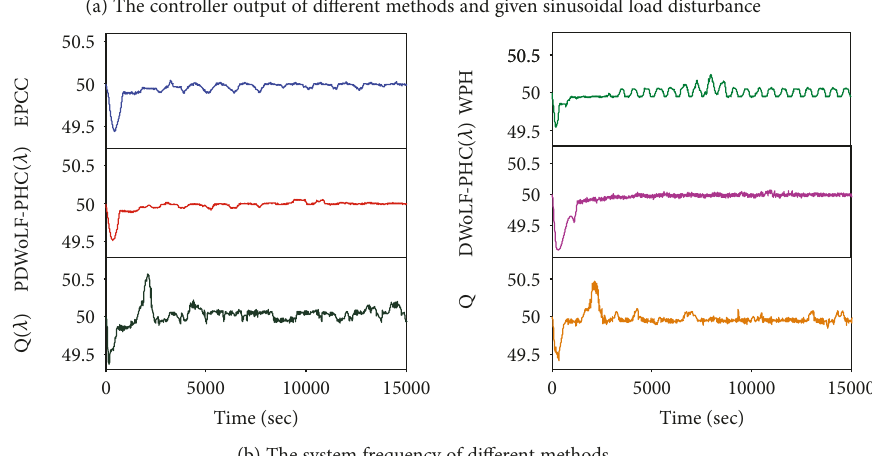
(a) The controller output of di ff erent methods and given sinusoidal load disturbance